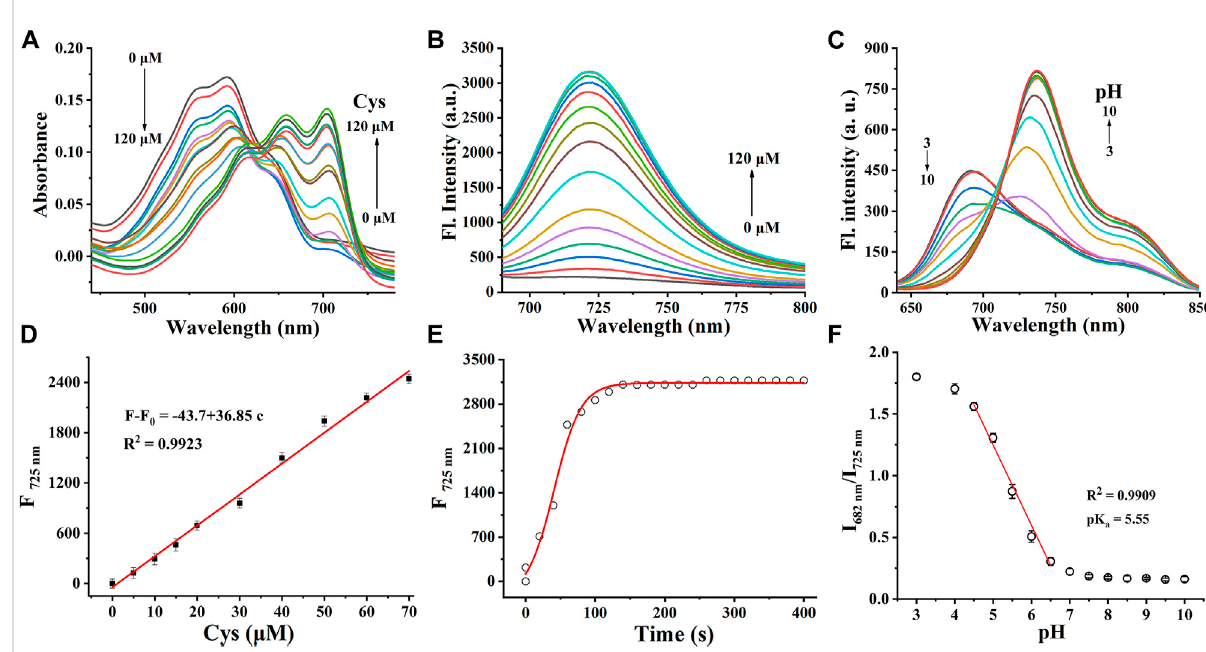
FIGURE 1 (A) Absorption spectra and (B) fl uorescence responses of Cy-Cys-pH (10 μ M) obtained upon addition with Cys from 0 to 120 μ M. (C) Fluorescence spectra of Cy-Cys-OH (10 μ M) in the buffer solution (pH, 3.0 – 10.0). (D) Plot of the fl uorescence intensity versus Cys concentrations. (E) Time pro fi leof Cy-Cys-pH reaction withCys. (F) PlotofI 682 /I 725 vs.pH intherange of3.0 – 10.0 and thelinear- fi tting curveofI 682 /I 725 vs.pH from 4.5 to 6.5. Error bar: mean ± SD, n =